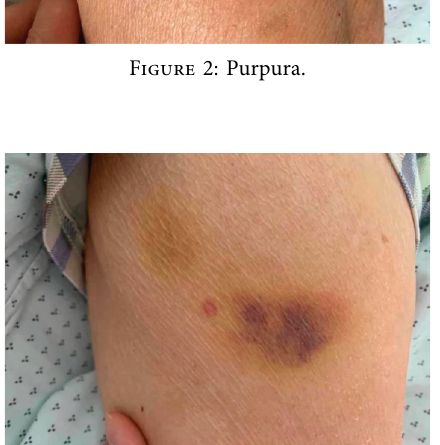
Figure 3: Ecchymosis.